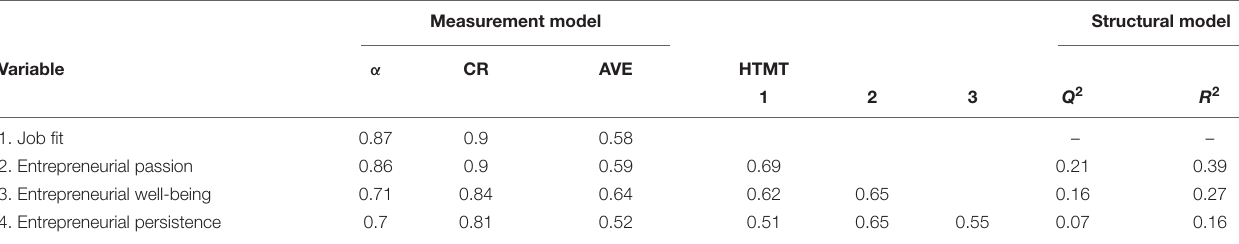
TABLE 2 | Assessment results of the measurement and structural models.